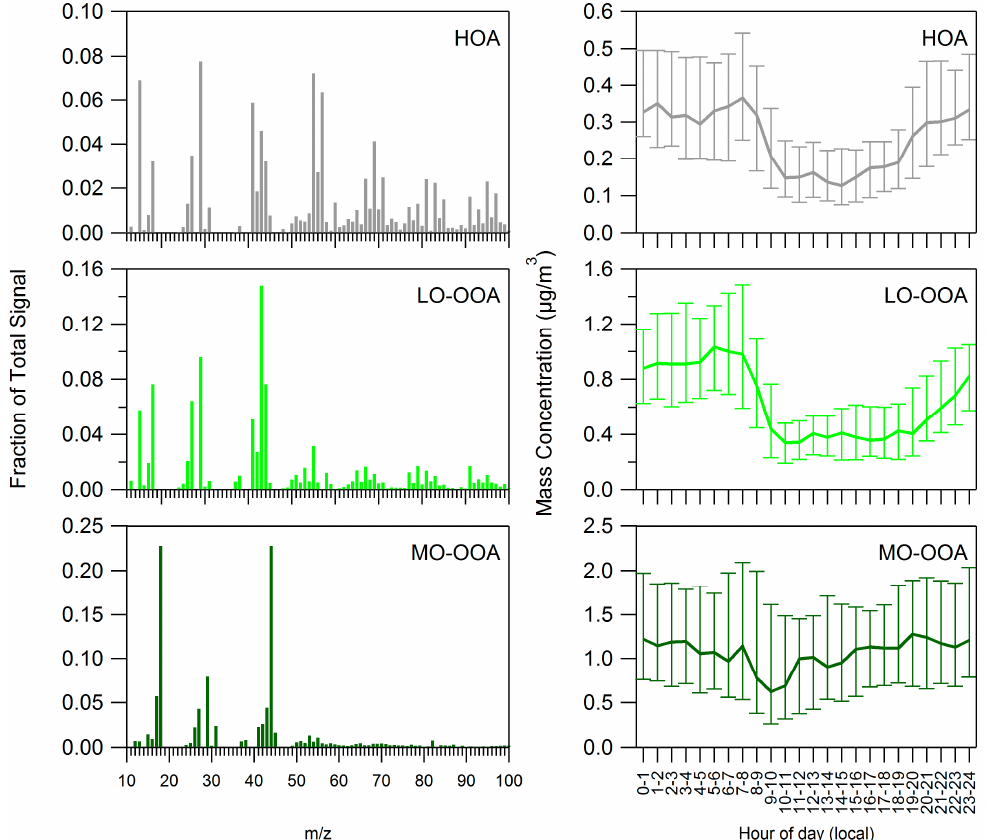
Figure 3. Mass spectra ( left ) and diurnal profiles ( right ) of PMF factors.